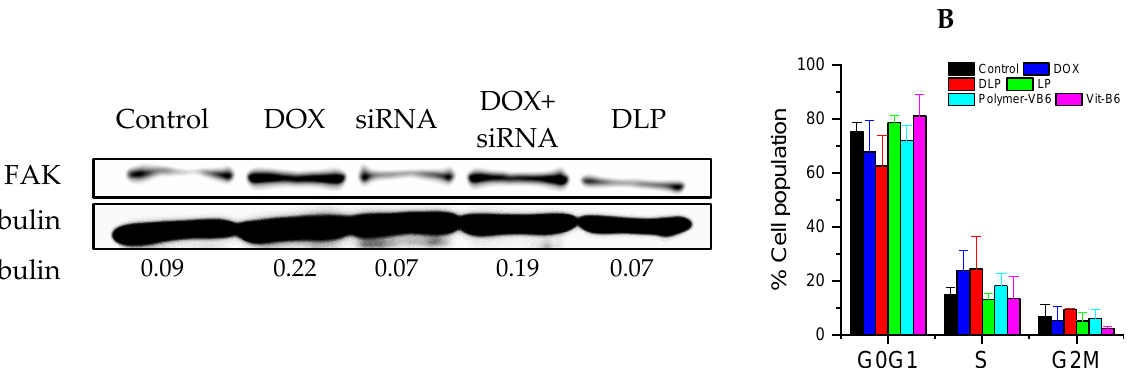
Figure 6. Cytotoxicity of lipopolyplexes in HCT116 cancer cells and L929 fibroblasts. ( A ) HCT116 cells and ( B ) L929 fibroblasts treated with VB6 and P(HPMA-co-MA-hyd-VB6) (Polymer-VB6) for 48 h. Free FAK siRNA and LP incubated with ( C ) HCT116 cells and ( D ) L929 for 48 h. ( E ) HCT116 cells and ( F ) L929 fibroblasts treated with free DOX, DL and DLP for 48 h. Data were presented as mean ± SD ( n = 3). * p < 0.05, ** p < 0.01 and *** p < 0.001.